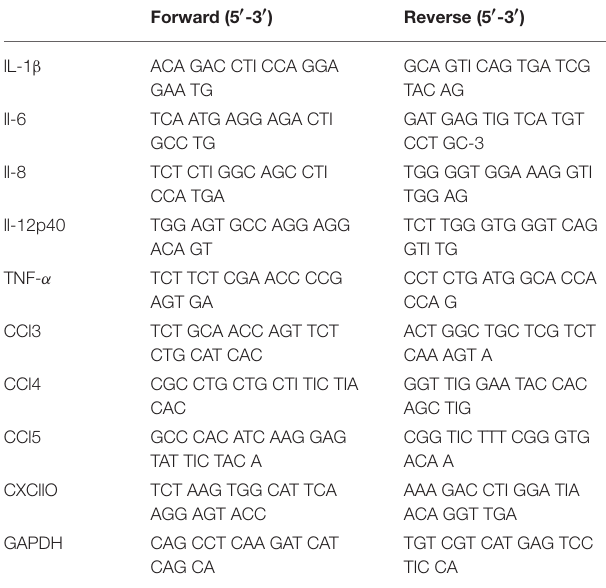
TABLE 1 | Forward and Reverse primers for q-PCR tested cytokines and chemokines. Forward (5 ′ -3 ′